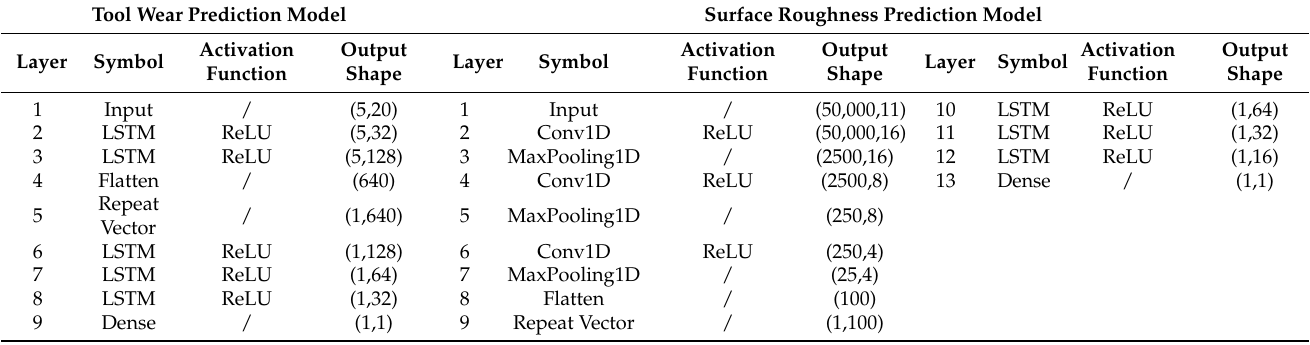
Table 6. The hyper-parameter settings of the tool wear prediction model and surface roughness prediction